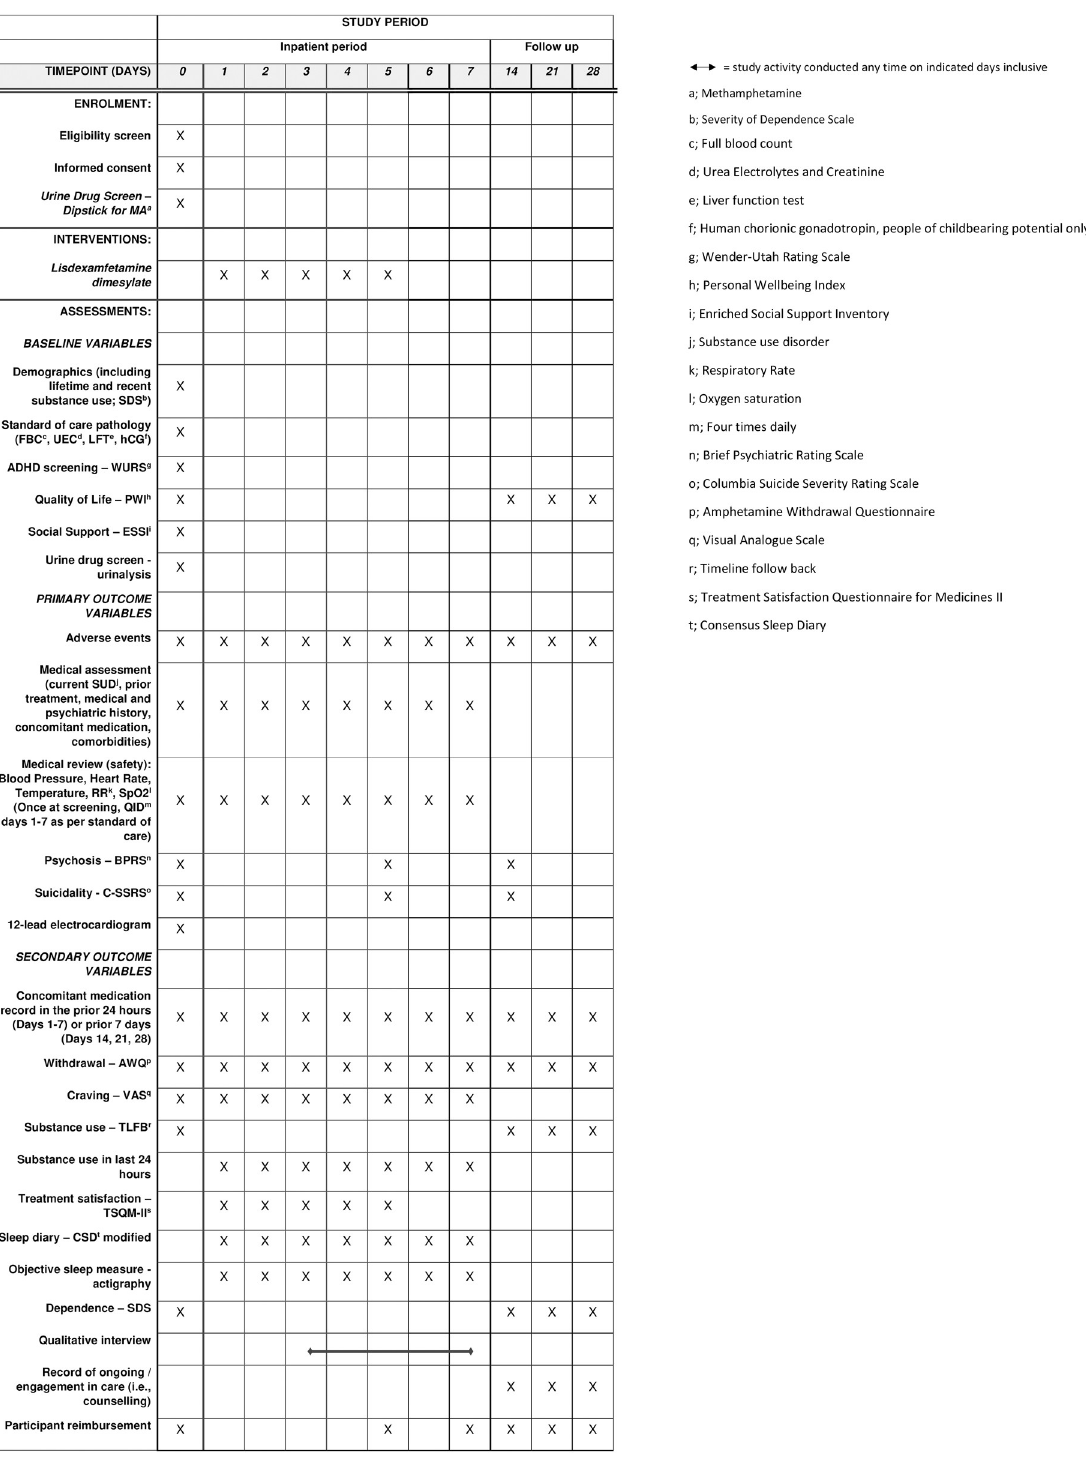
Fig 1. Schedule of enrolment, interventions, and assessments.